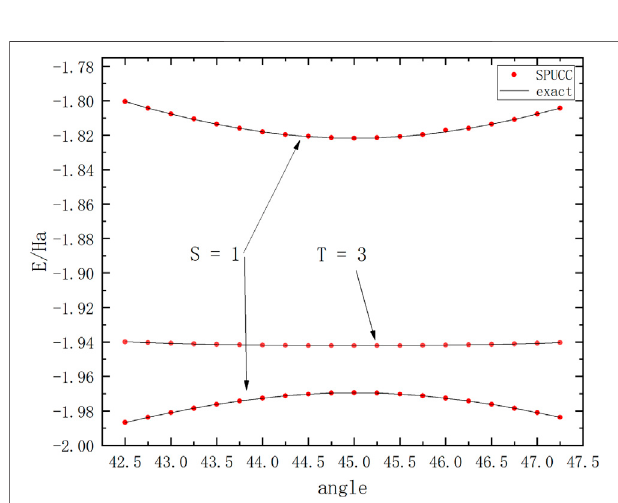
FIGURE 6 | A graph in which the energy of a molecule H 4 varies with bond length (6 electrons and 10 orbitals). The S (cid:1) 1 represents the singlet state, and the T (cid:1) 3 represents the triplet state. From the bottom up, they are the ground state, the fi rst and second excited states of the